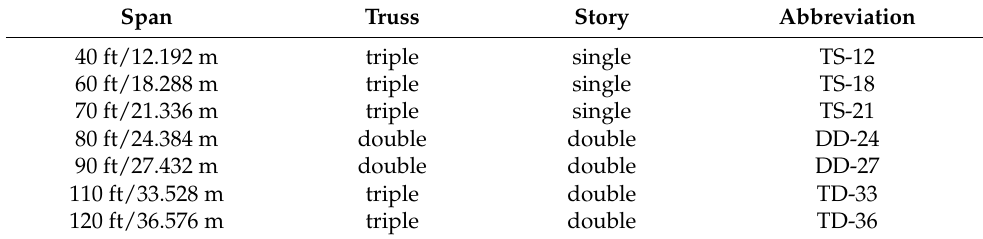
Table 1. Spans and BB arrangement of the chosen alternatives. Span Truss Story